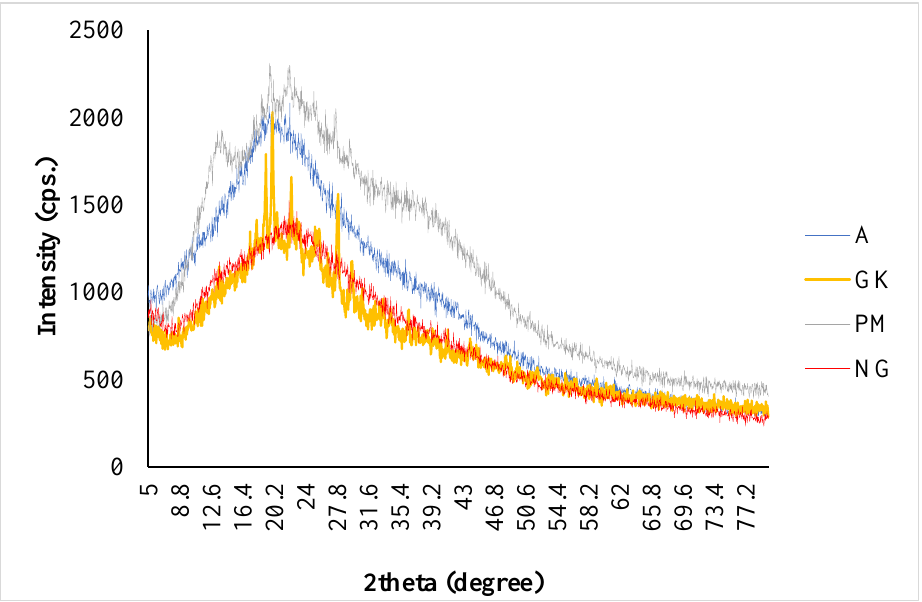
Figure 2. PXRD characterizations of Ginkgo biloba ginkgo extract (GK), alginate (A), their dry physical mixture (PM), and nanocomplex gel (NG).